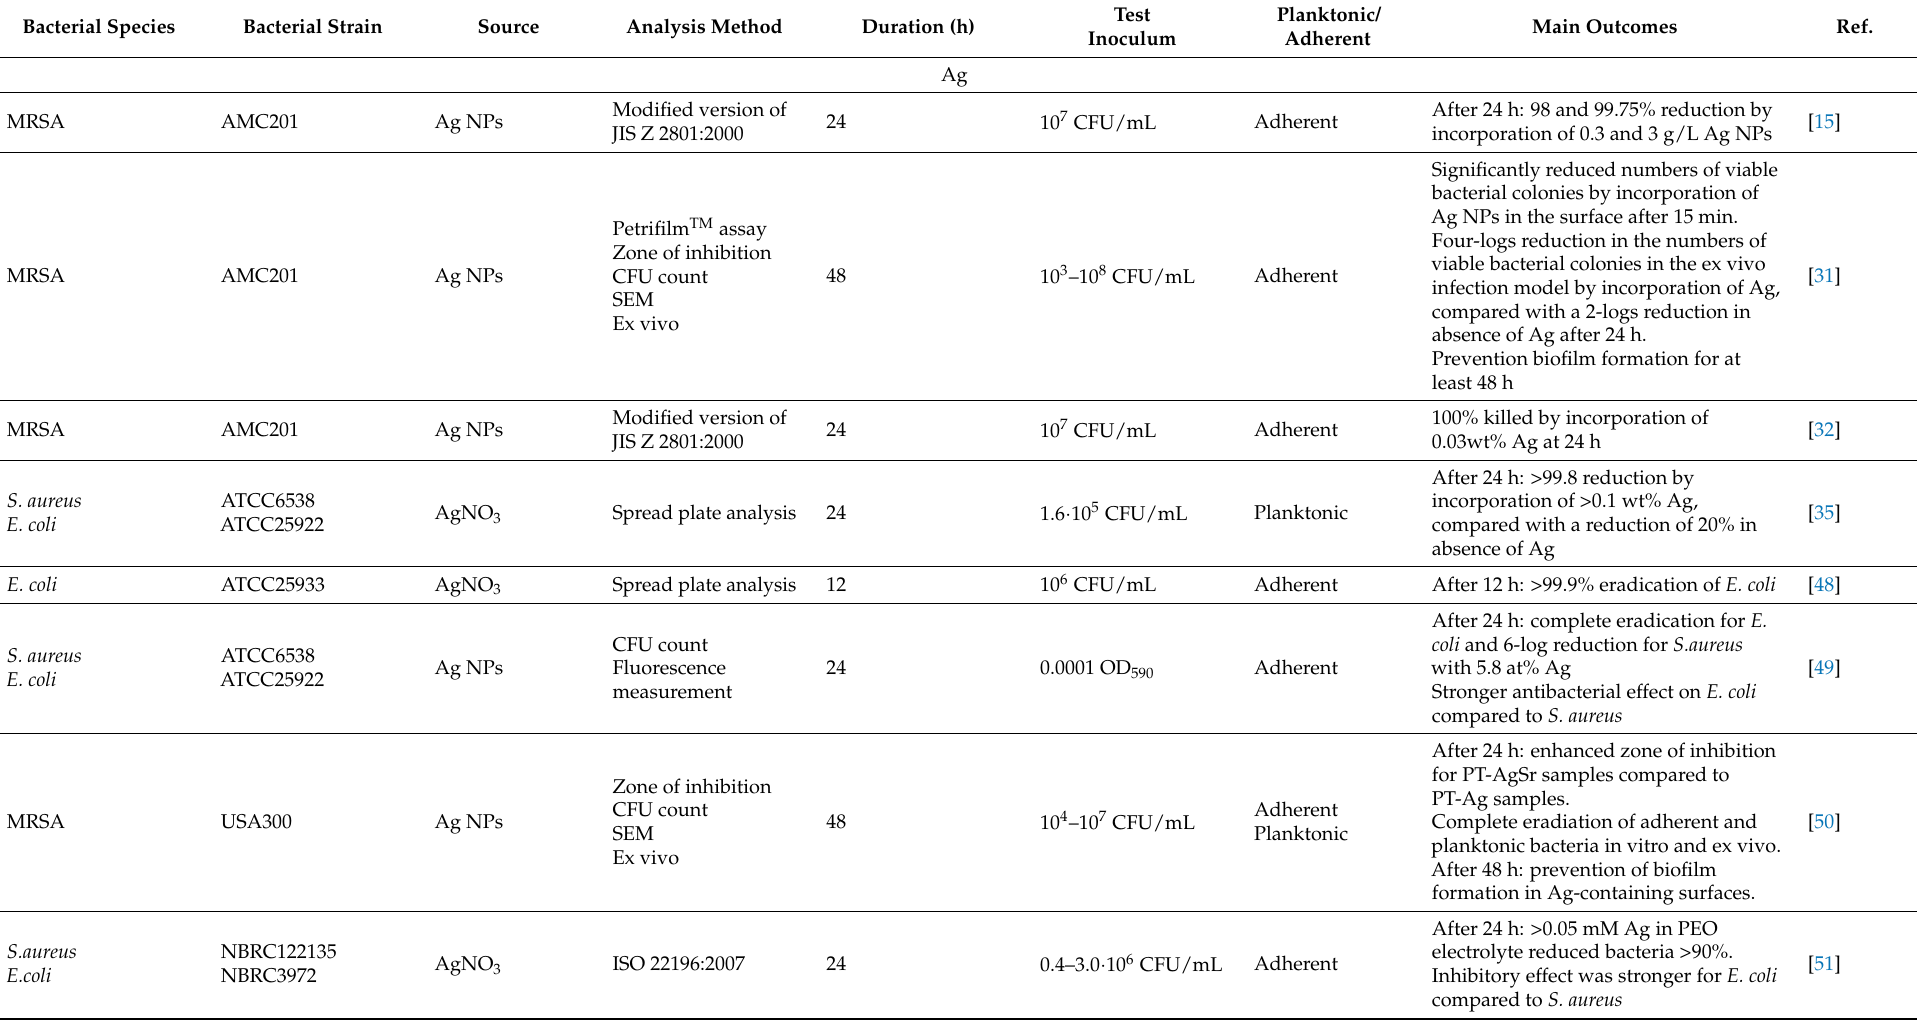
Table 5. Antibacterial tests and results on PEO-modified Ti-surfaces bearing single or multiple